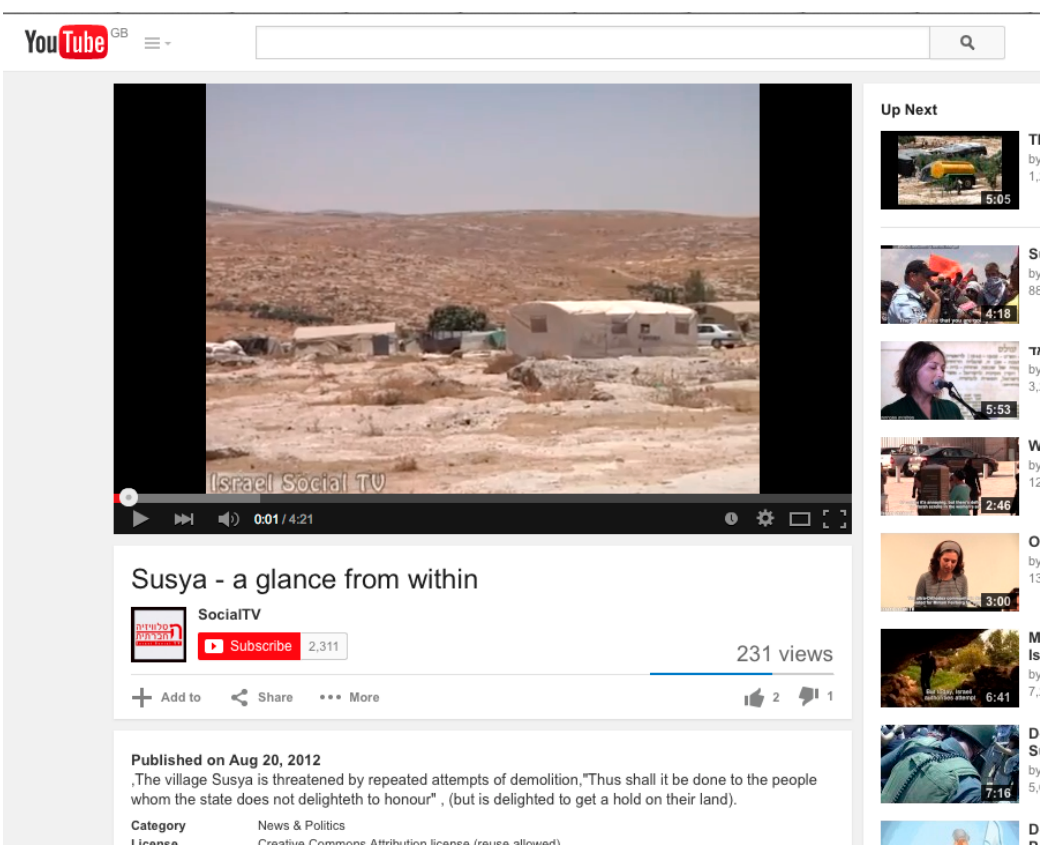
Figure 11. Screen grab from Social TV’s feature on Susiya—‘A Glance from Within’. (Accessed on 14 September